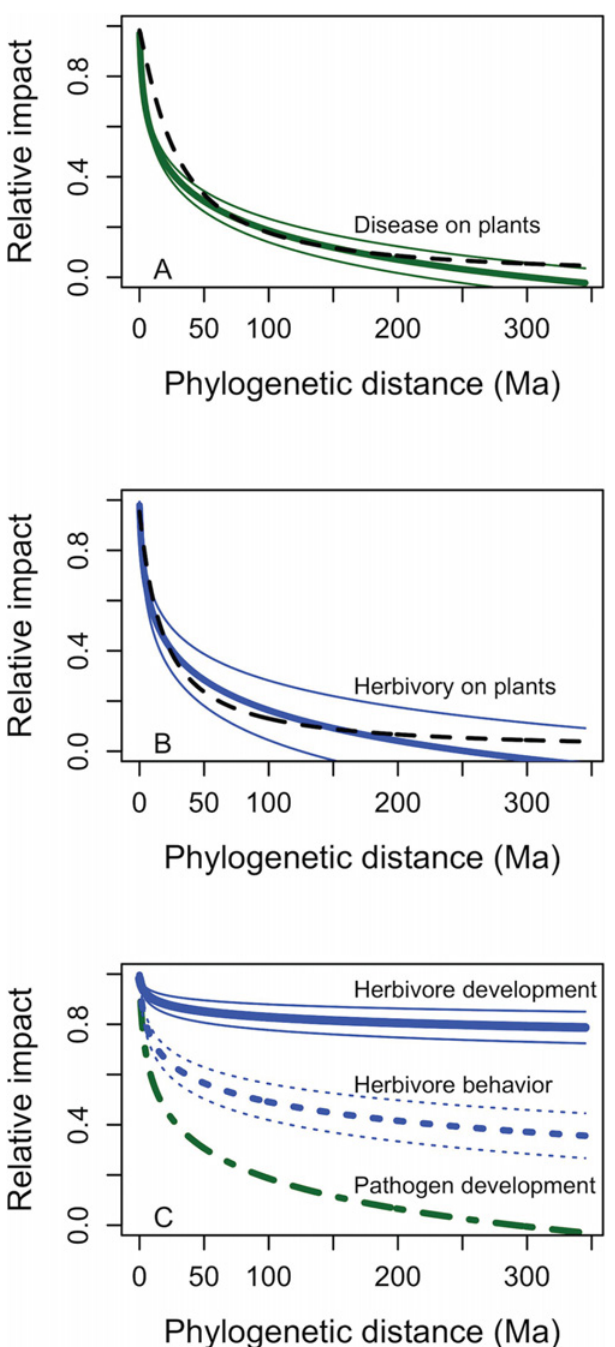
Fig 1. Observed phylogenetic signal in severity of impact of plant-enemy interactions. Regressions are based on weighted mean regression coefficients of relative impact on the log of the phylogenetic distance between hosts in meta-analysis of published studies. Regression coefficients are given in Table 1. Thick lines are based on mean intercept and slope, and the thin lines are 95% confidence intervals. For comparison in panels A and B, the dashed black lines show the expected probability that two hosts at that phylogenetic distance would share a particular enemy based on re-analysis of data in Gilbert et al. [18], using the present phylogenetic tree. In panel C, Pathogen development has no confidence intervals because it was derived from only one study unit (Table 1, S1 Fig, S1 Table).